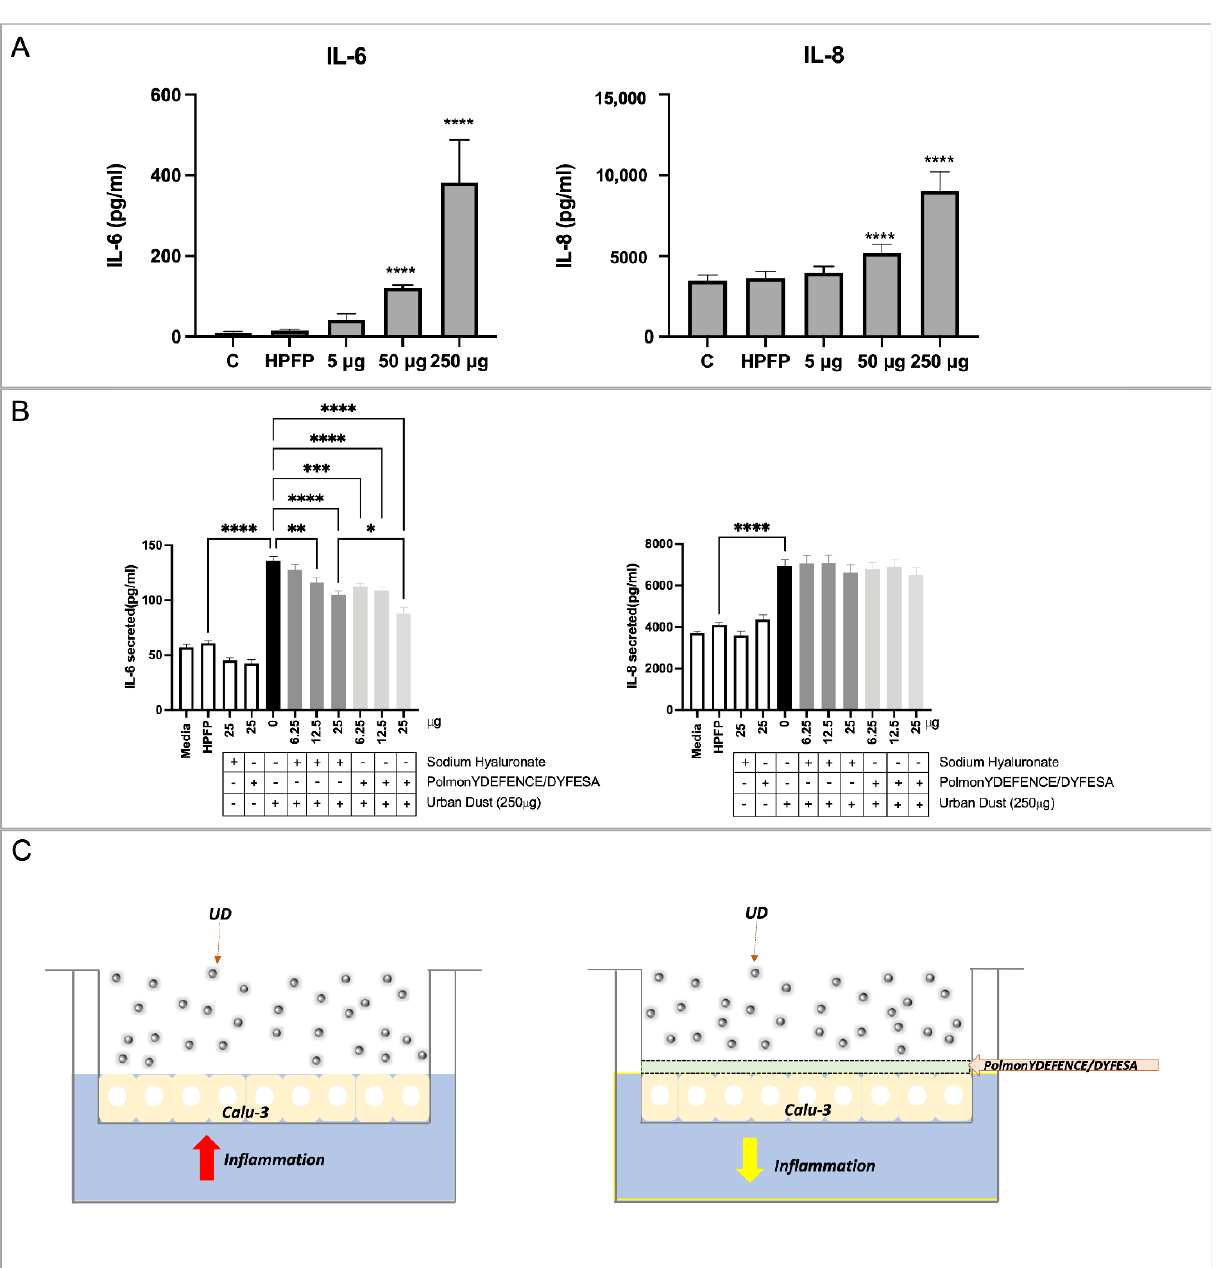
Figure 3. ELISA assays detecting interleukins 6 and 8 in Calu-3 cells in ALI culture using ( A ) increased concentrations of urban dust. Statistical significance is determined by comparing all conditions to vehicle control (HPFP), ( B ) using the main ingredients alone or in combination with urban dust (250 µ g), statistical significance is determined between the comparison of HPFP to Media, Na–Hya only, PolmonYDEFENCE/DYFESA only, and urban dust only. Further comparisons were made between urban dust only compared to all other conditions with urban dust and Na–Hya compared to PolmonYDEFENCE/DYFESA, both with urban dust. An ordinary one–way ANOVA with Sidak’s multiple comparisons test was used (* p < 0.033; ** p < 0.0021; *** p < 0.0002; **** p < 0.0001). ( C ) Visual representation of the barrier–forming mechanism of action of PolmonYDEFENCE/DYFESA in reducing urban dust–induced epithelial